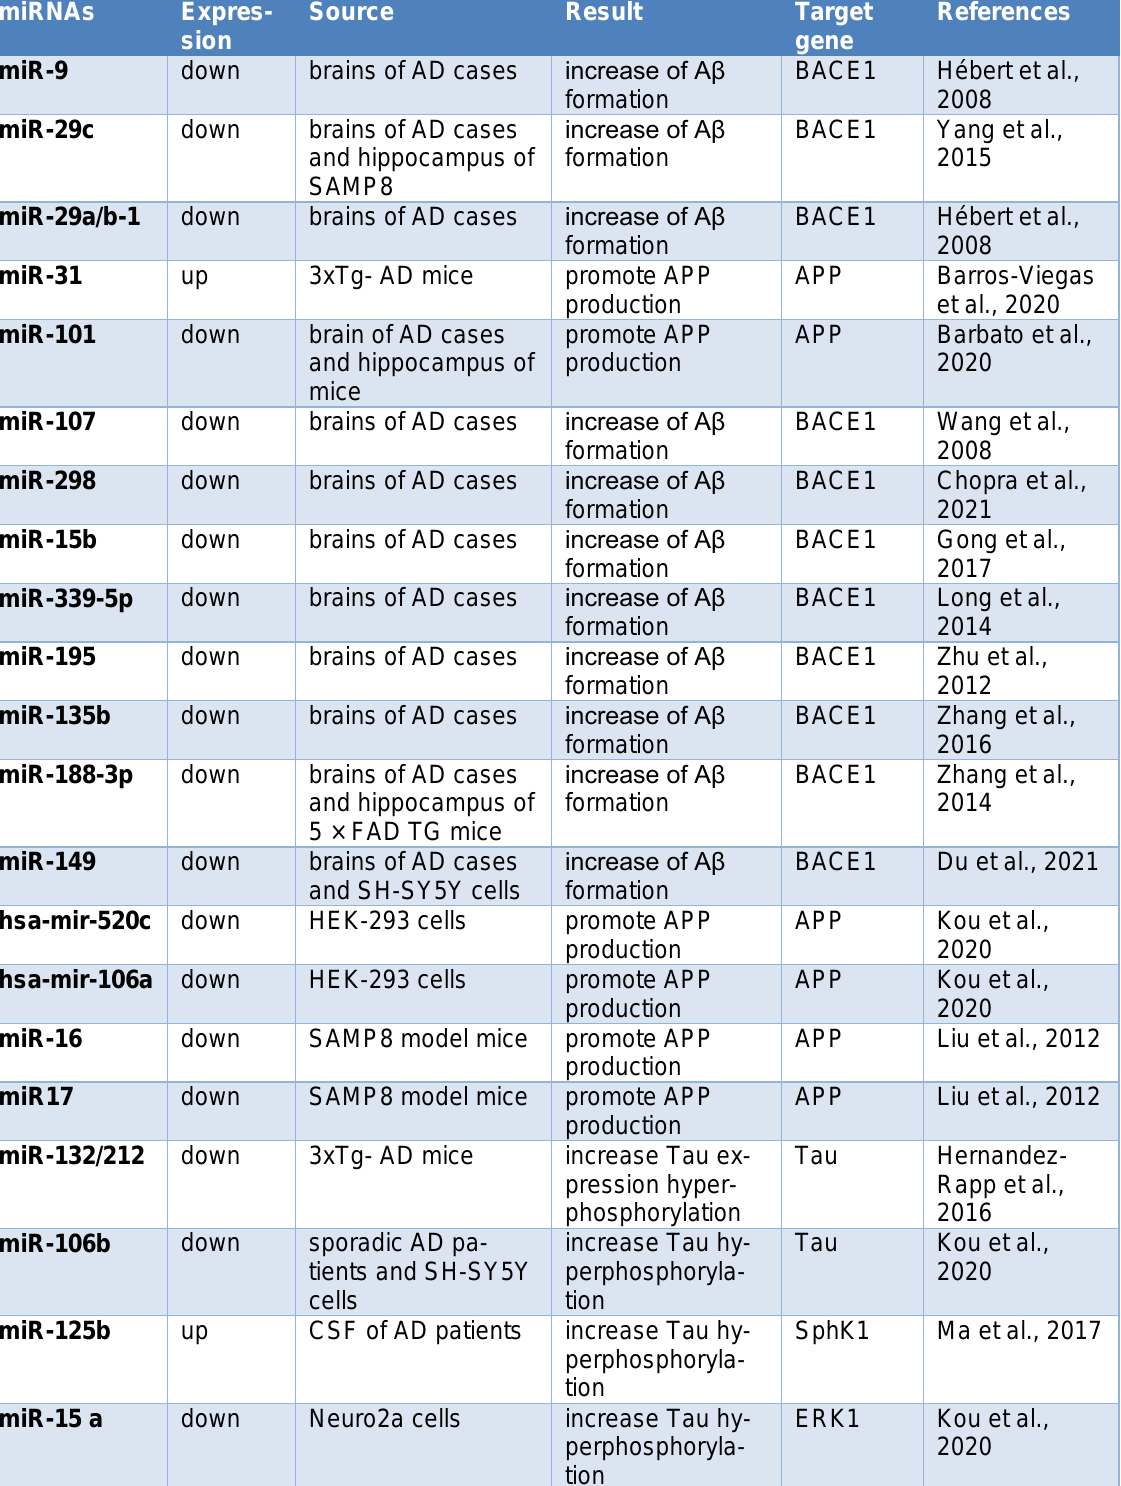
Table 2: A list of miRNAs that are involved in the regulation of BACE1, APP and tau processing